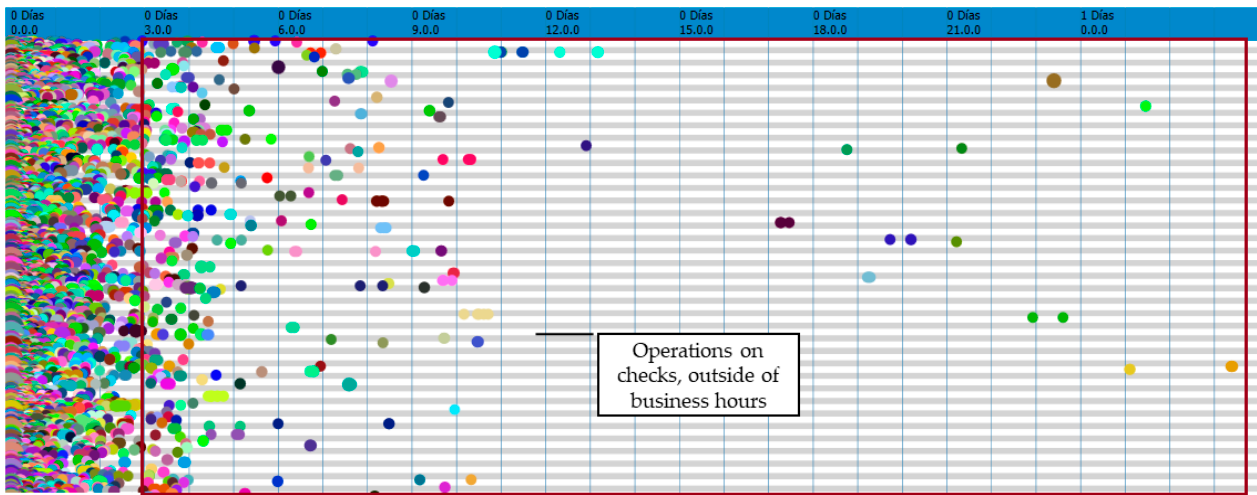
Figure 6. View of the duration of the instances using a dotted chart.